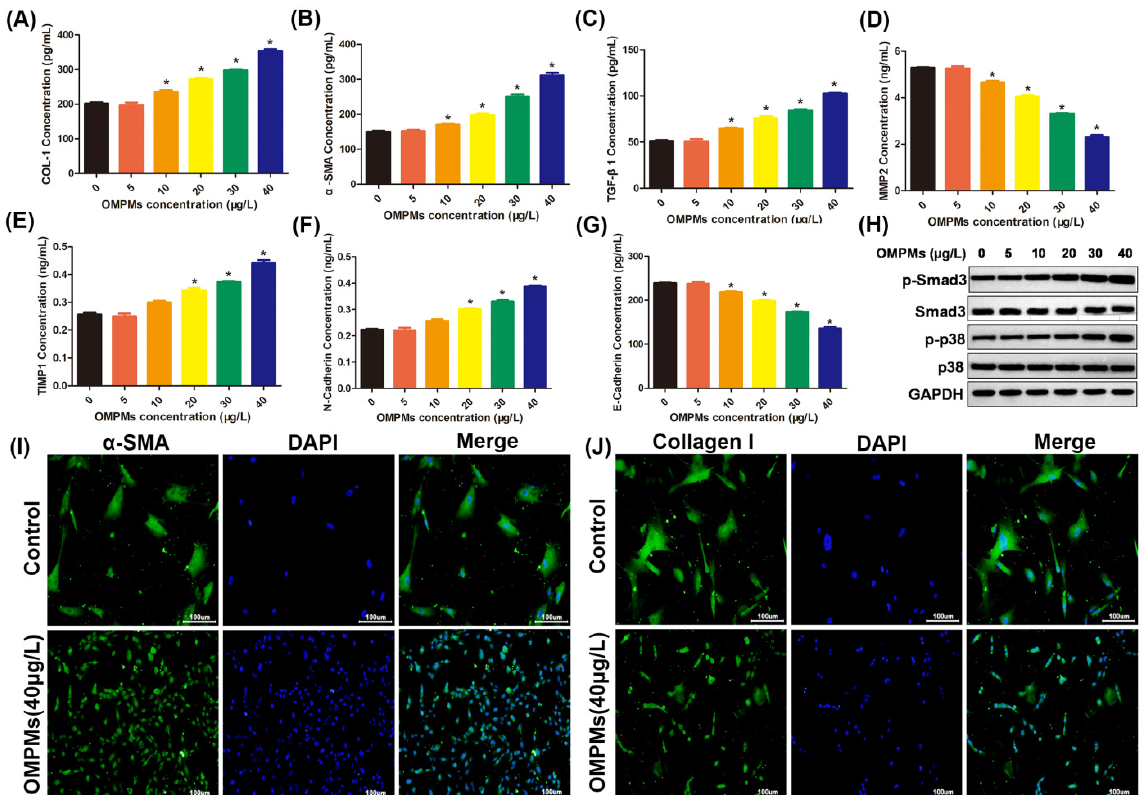
Figure 5. OMPM exposure activated the differentiation of the HFL-1 cell line. ( A ) COL-1 concentration; ( B ) α -SMA concentration; ( C ) TGF- β 1 concentration; ( D ) MMP2 concentration; ( E ) TIMP1 concentration; ( F ) N-Cadherin concentration; ( G ) E-cadherin concentration. ( H ) Phosphorylation of Smad3 and p38 after OMPM exposure detected with Western blotting. ( I ) α -SMA expression after OMPM exposure was detected using immunofluorescence. ( J ) Collagen I expression after OMPM exposure was detected using immunofluorescence; 100×, bar: 100 μ m. Data represent mean ± SD. * p < 0.05 vs. the control group.